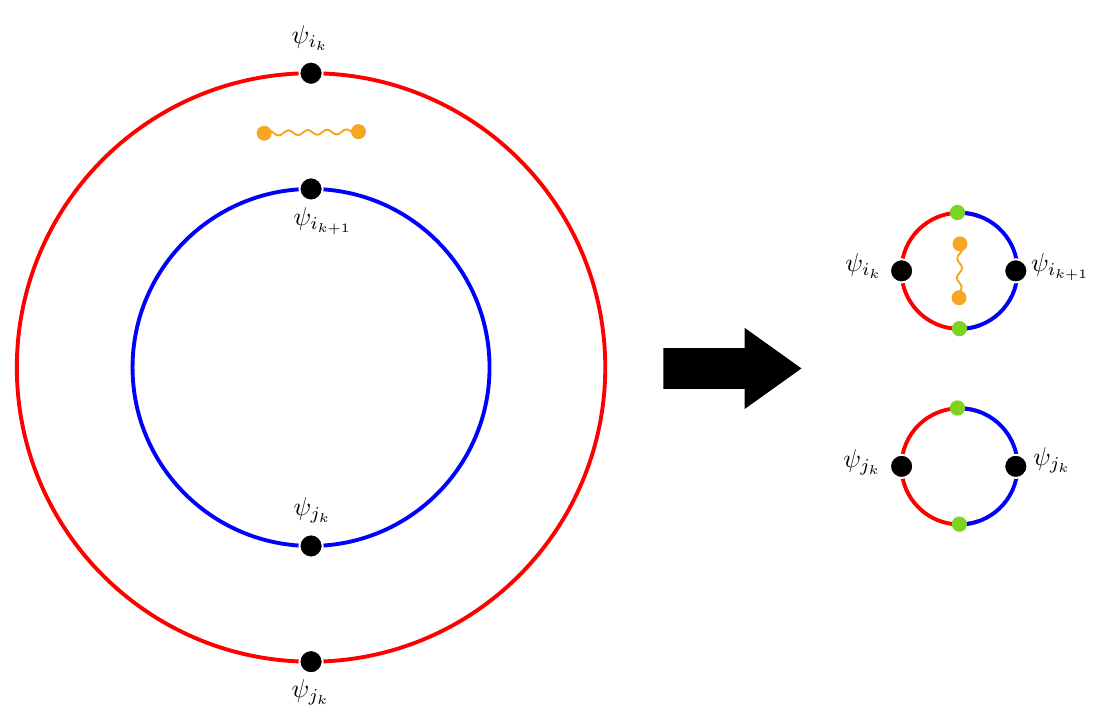
Figure 5 . Left : schematic picture of the annulus geometry M 2 n / Z n . This annulus geometry has a cut (orange line) whose endpoints are the fixed points of the replica symmetry. Right : schematic picture of the two disc geometries, which are obtained from the annulus geometry (left figure) by taking the β → 0 limit. One of the two disks contains a cut (orange line). The green dots are boundary condition changing points between the two conditions of the universes A and B